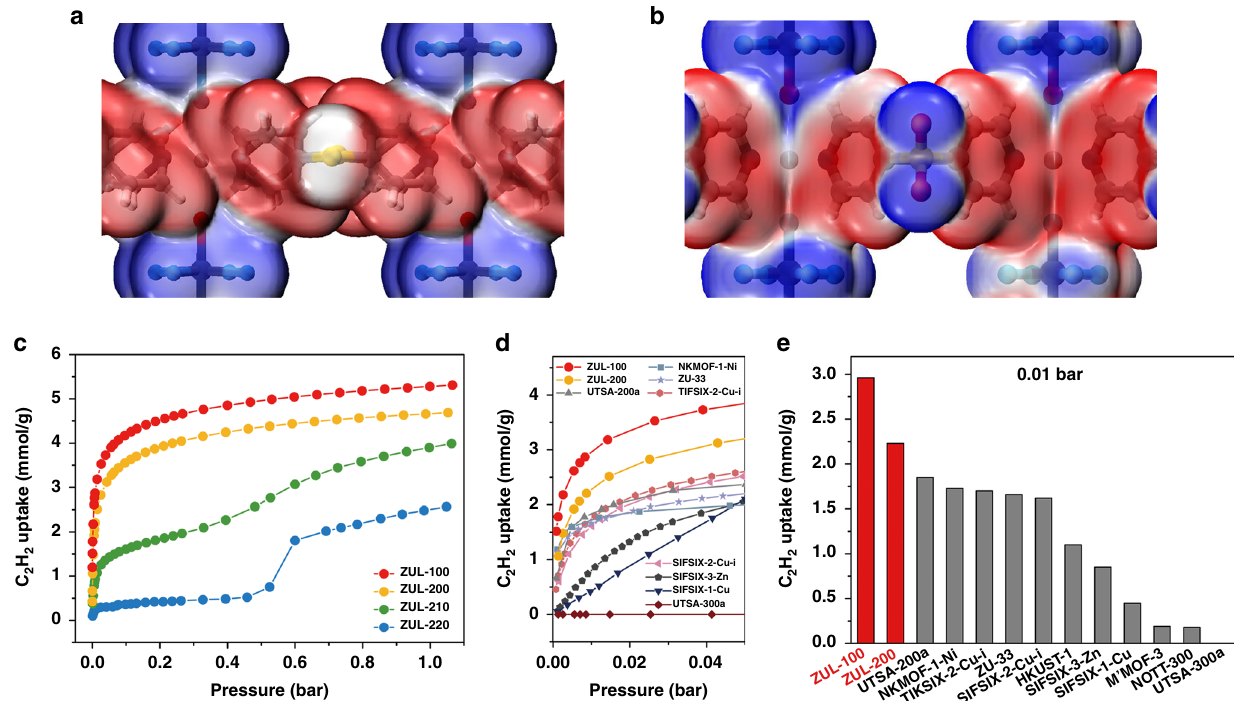
Fig. 2 Surface electrostatic potential and C 2 H 2 adsorption isotherms of the MOFs. a , b The local surface electrostatic potential of the 2D network in ( a ) ZUL-220 and ( b ) ZUL-200 mapped onto the 0.001 a.u. density isosurface with a scale spanning − 0.03 a.u. (blue) through 0 (white) to 0.03 a.u. (red). c The C 2 H 2 adsorption isotherms at 298 K for ZUL-100, ZUL-200, ZUL-210, and ZUL-220. d Comparison of C 2 H 2 uptake (0 – 0.05 bar) among representative MOFs at 298 K. e Comparison of C 2 H 2 uptake (0.01bar, 298 K) among representative